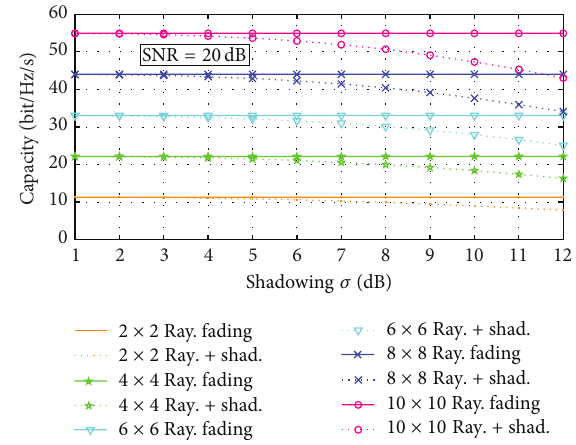
Figure 3: Capacity versus shadowing fading, with SNR = 20